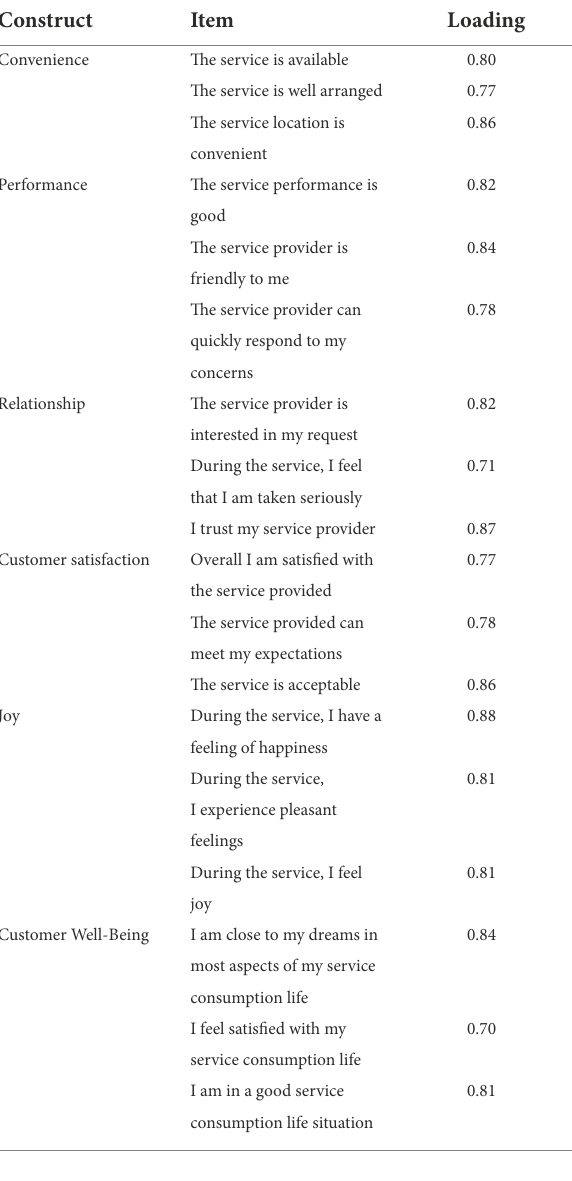
TABLE 4 Correlation matrix of ETA and KSI.